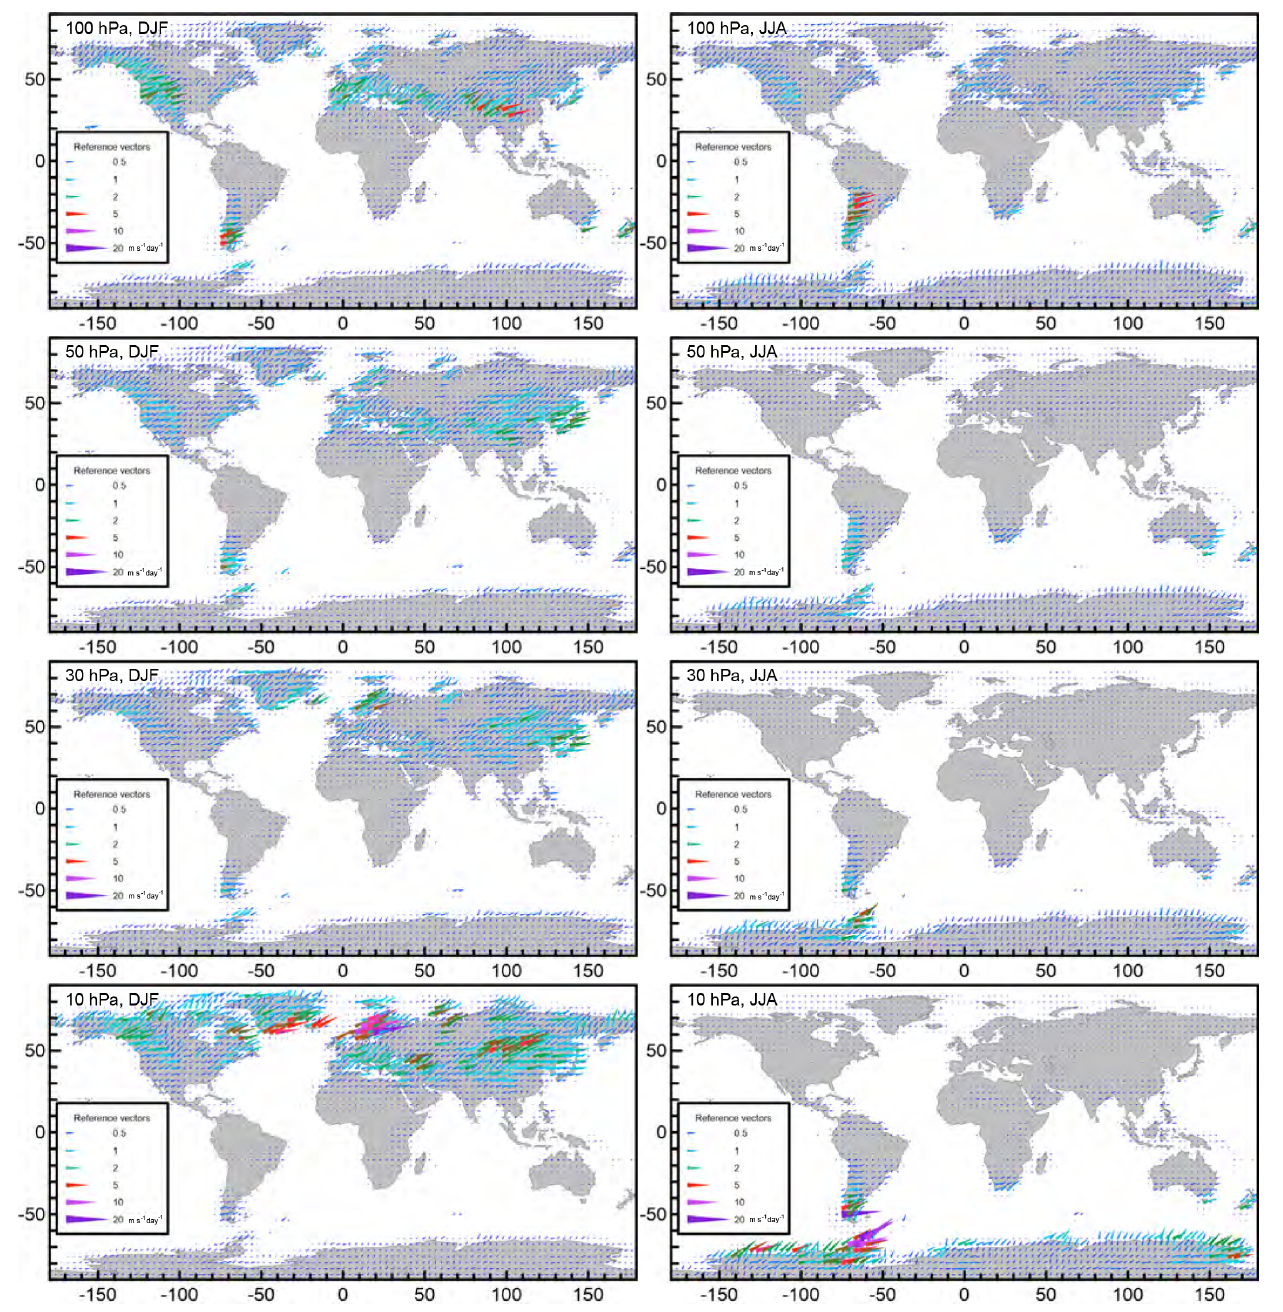
Figure 2. Standard deviation (SD) of the monthly series of wind tendency due to OGW (ms − 1 day − 1 ), displayed in a vector-like form and assigning the value for the eastward component to the x axis and value for the northward component to the y